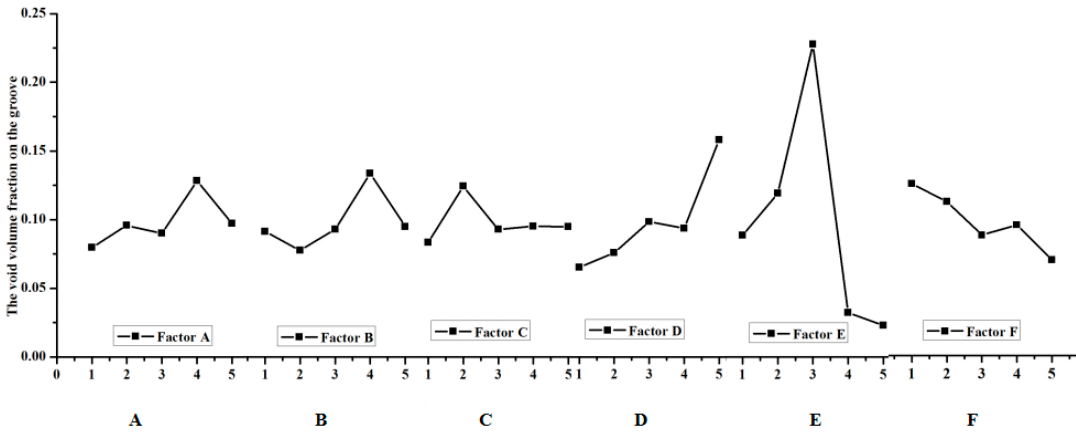
Figure 6. Effect of process parameters on the fracture location on the groove.